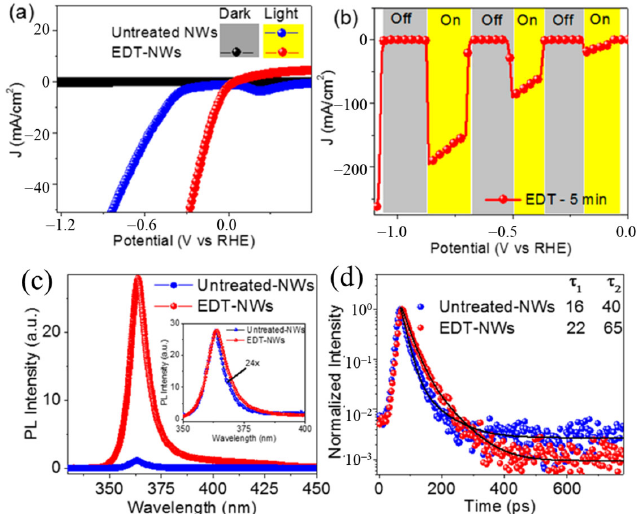
Figure 6. ( a ) Linear sweep voltammetry of untreated NWs and EDT-NWs. ( b ) Chopped illumination J − V curve of EDT-NWs. ( c ) Room-temperature PL of untreated NWs and EDT-NWs. The inset in ( c ) shows the untreated NWs’ intensity multiplied by 24 to normalize it with the PL intensity of the EDT-NWs. ( d ) TRPL carrier lifetimes of the untreated-NWs and EDT-NWs. The fast and slow decay time constants ( τ 1 and τ 2) are indicated in the figure. Reproduced from [25] with permission.